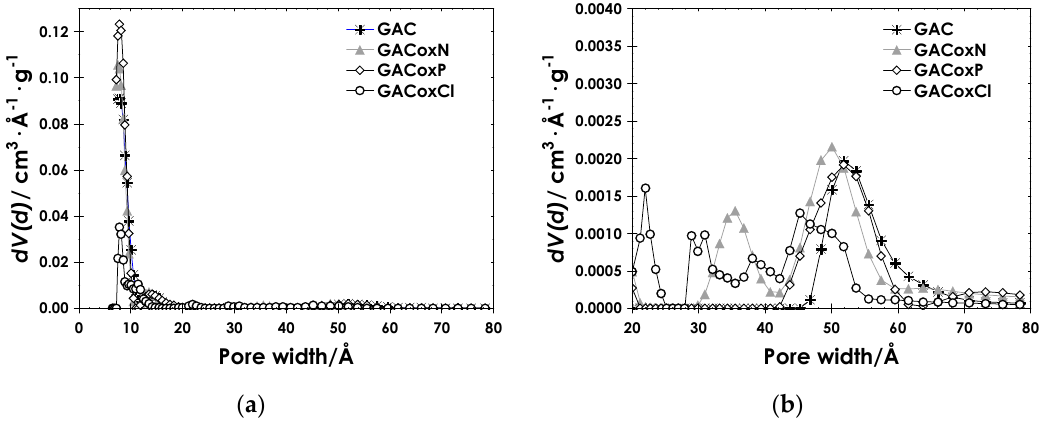
Figure 3. Pore size distribution of ( a ) GAC, GACoxN, GACoxP, and GACoxCl; ( b ) Zooming of a graphic in the range 20–80 Å.